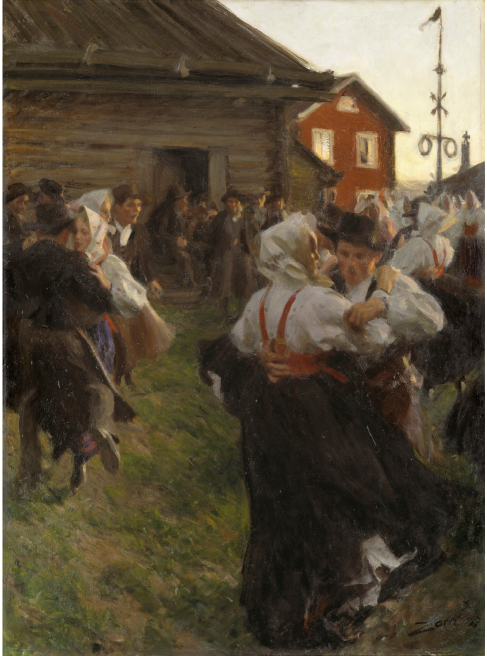
Figure 6. Anders Zorn (1860–1920): Midsommardans (“Midsummer Dance”), 1897, oil on canvas, 140 cm × 98 cm, Nationalmuseum Stockholm, Public